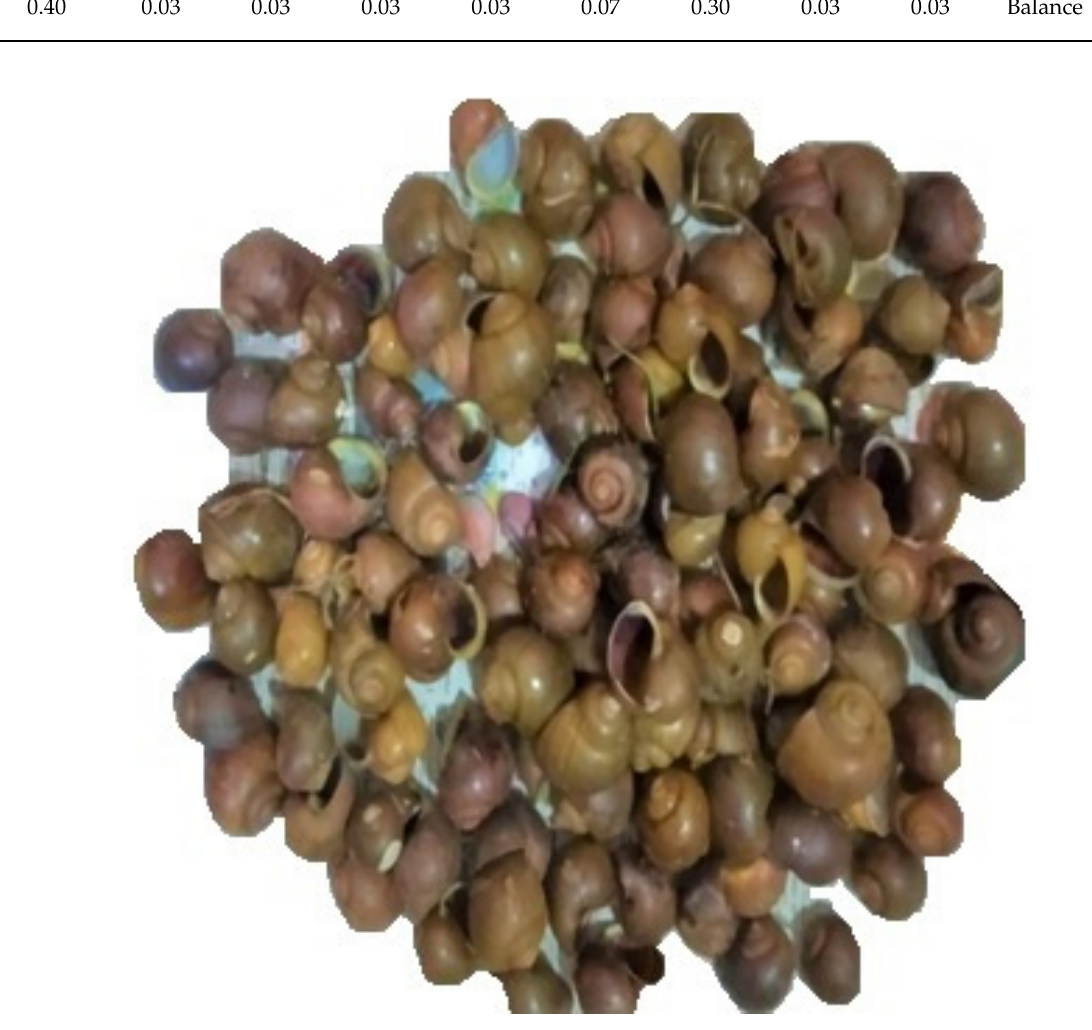
Figure 1. Physella Acuta Fresh water pond snail shells.